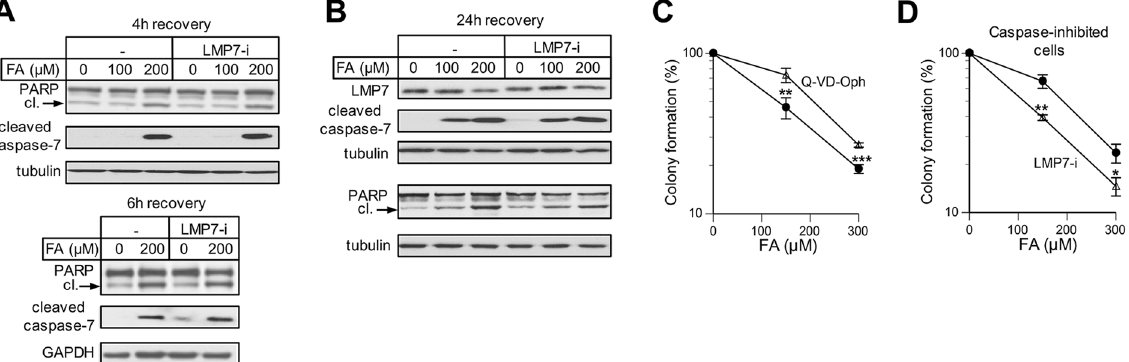
Figure 4. Apoptosis in cells with inactive i-proteasomes. H460 cells were treated with FA for 3 h in the presence or absence of 0.5 μ M LMP7-i. The inhibitor was also present during the indicated recovery times. ( A ) Westerns for apoptotic markers at 4 h and 6 h recovery or ( B ) 24 h recovery post-FA treatments (cl.- cleaved PARP). ( C ) Effect of the pancaspase inhibitor Q-VD-Oph (20 μ M) on survival of H460 cells. Q-VD-Oph was present during FA treatments and 72 h post-FA (means ± SD, ** p < 0.01, *** p < 0.001, n = 3). (( D ) Impact of LMP7-i on FA toxicity in the presence of the pancaspase inhibitor Q-VD-Oph (20 μ M). LMP7-i was coincubated with FA for 3 h and then added for additional 24 h. Data are means ± SD, * p < 0.05, ** p < 0.01, n = 3.